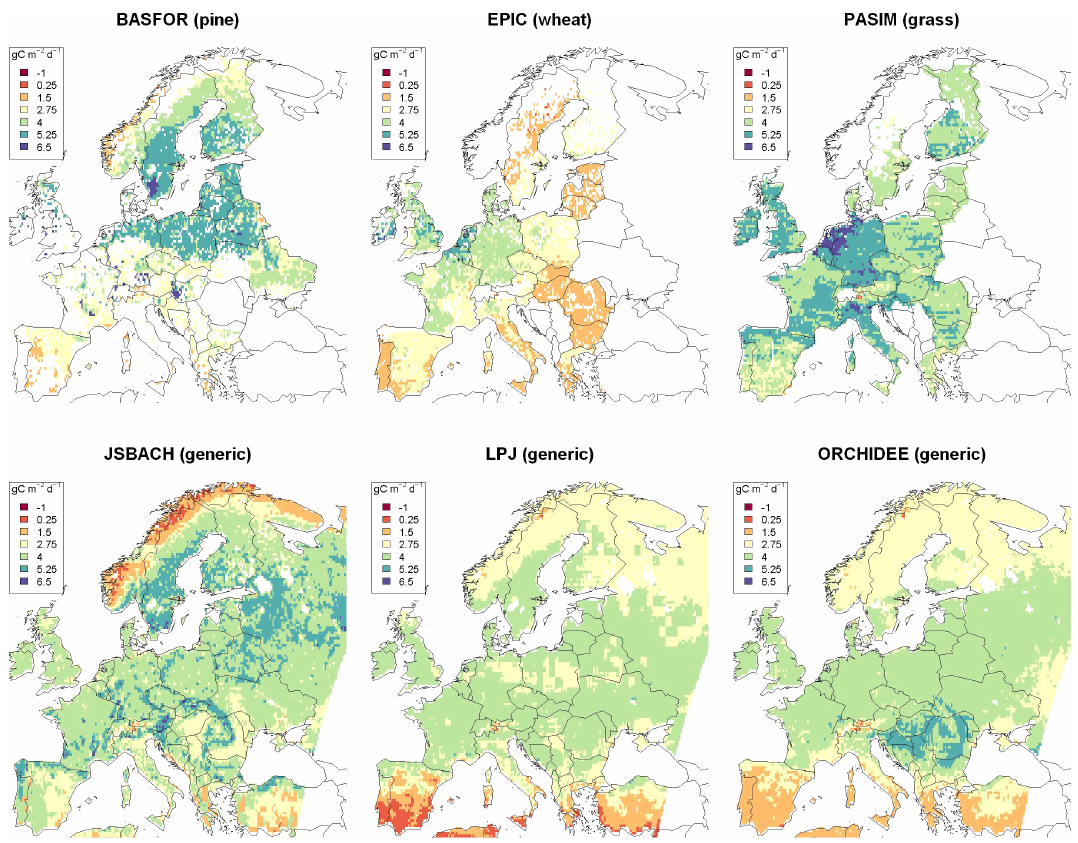
Figure 2. Average net primary productivity (NPP, gCm − 2 d − 1 ) for April to September in 1971–2000 for six different vegetation